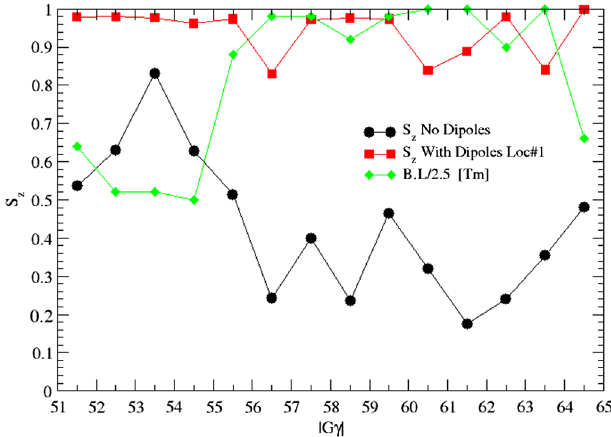
FIG. 6. The stable spin direction at the exit of the AtR line as a function of half integer j G γ j values. The black circles and the red squares correspond to the S values when the three dipoles at the z location ♯ 1 (green rectangles in Fig. 2) are not excited or excited respectively. The green diamonds is the integrated dipole field R B · d l = 2 . 5 at the location ♯ 1 .